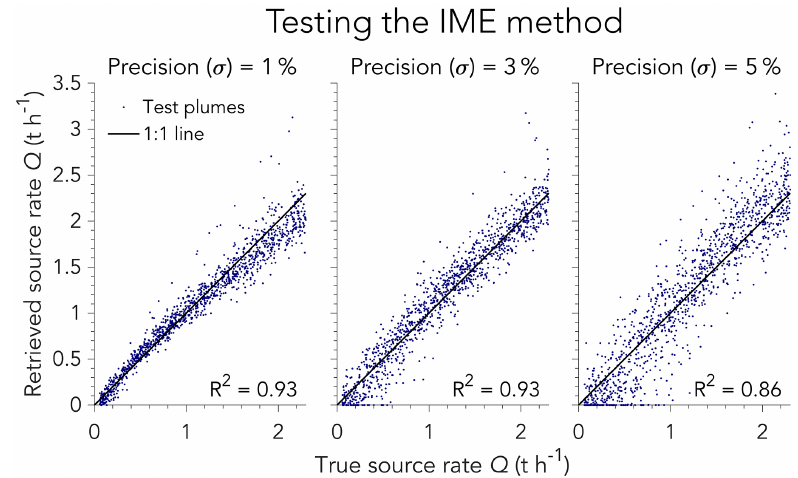
Figure 6. Evaluation of the IME method for retrieving source rates Q using the LES test set with three different instrument precisions (1%, 3%, 5%). The inset gives the coefficient of determination, R 2 .